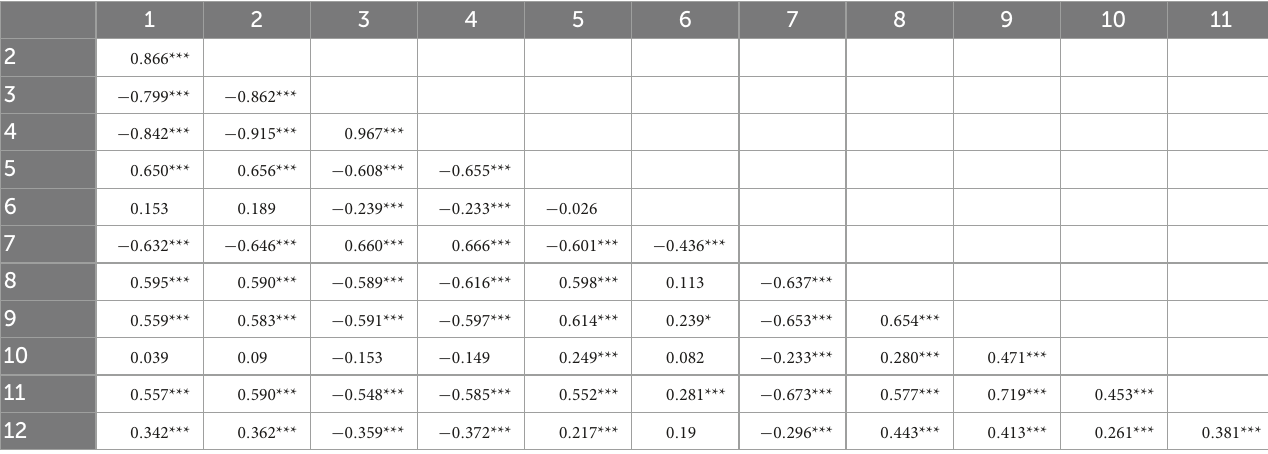
TABLE 3 Correlation results of group cohesion scores.